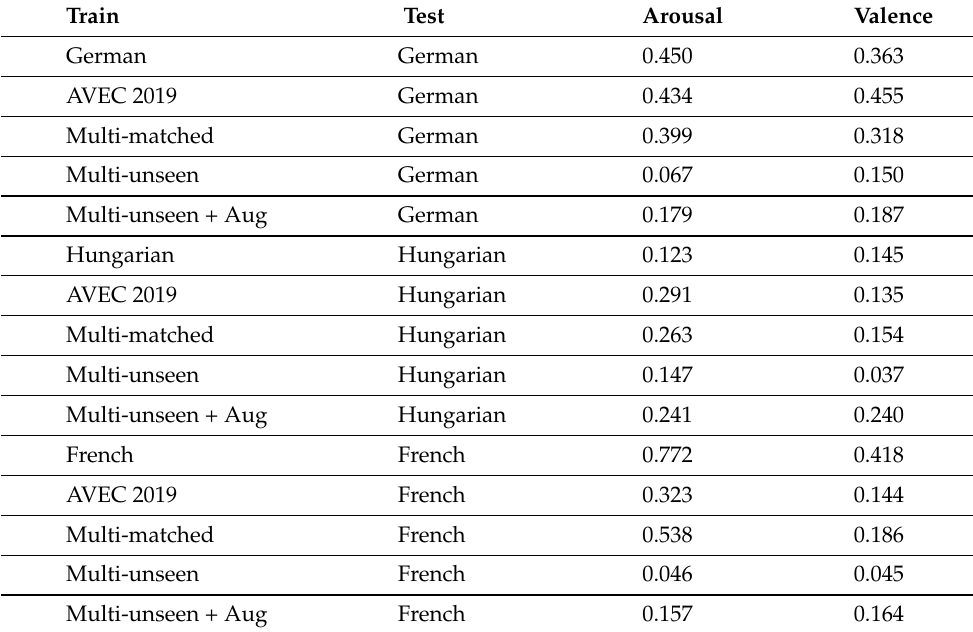
Table 1. Ablation study results for monolingual, multilingual with matched test language, and multilingual with unseen test language experiments, without and with (‘+Aug’) data